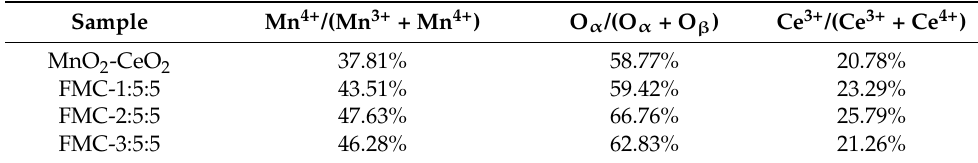
Table 4. Surface elemental composition of FMC